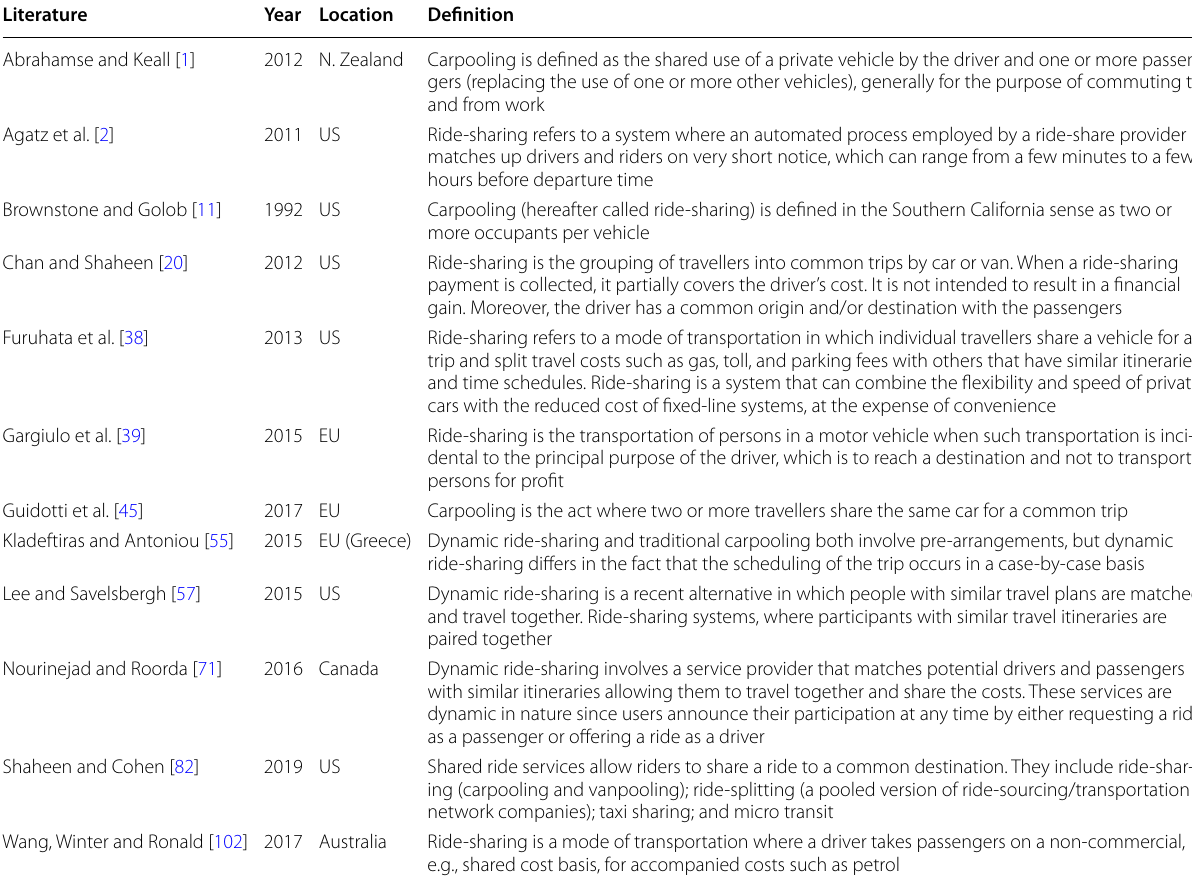
Table 2 Ride-sharing definitions within literature